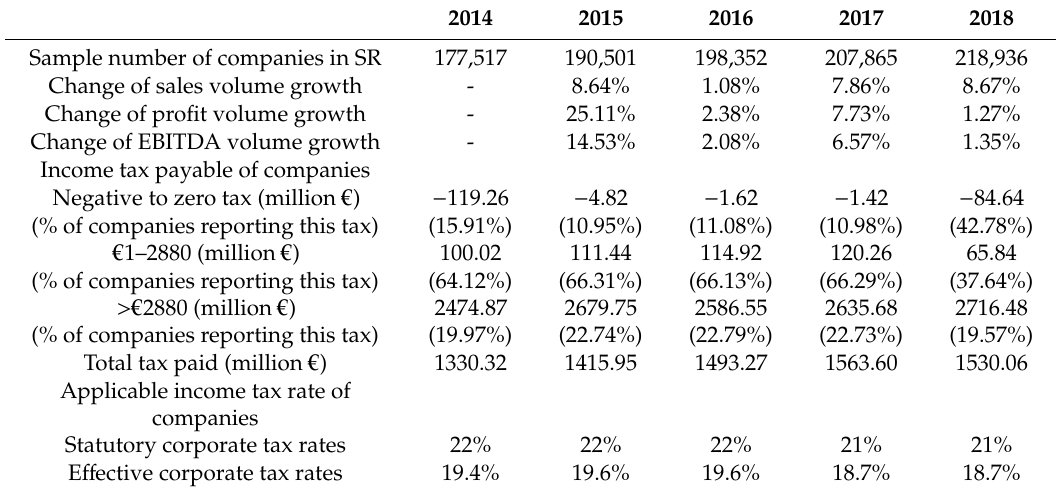
Table 4. The data characterizing the financial situation of the companies in the years from 2014 to